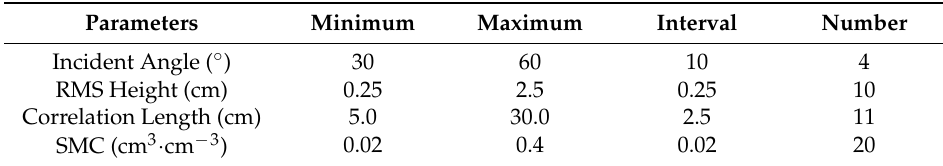
Table 1. Parameters of the surface conditions used in the effective reflectivity simulations (RMS: root mean square of surface height; SMC: soil moisture content).